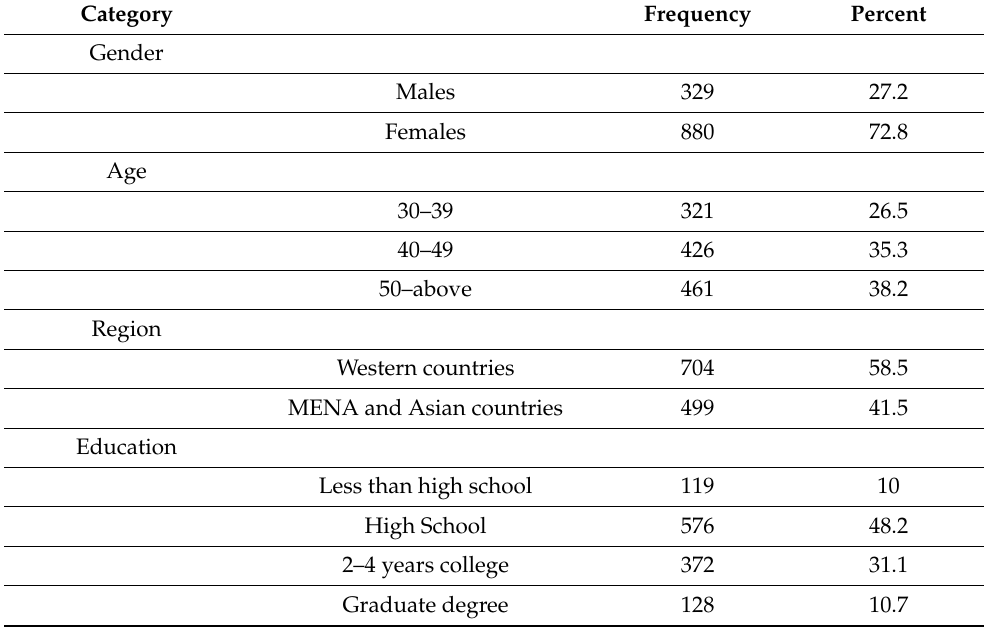
Table 1. Participants